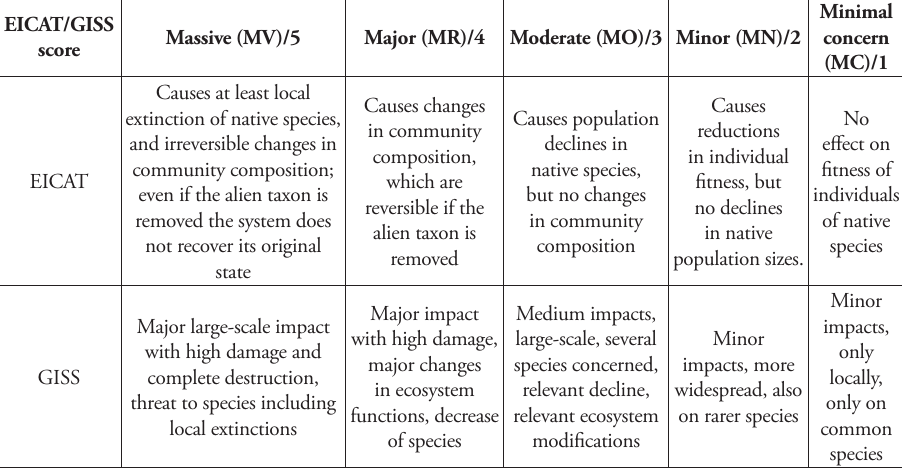
Table 1. Summary of GISS and EICAT scores applied across mechanisms (e.g., competition, hybridisa- tion, etc.). See Hawkins et al. (2015) and Nentwig et al. (2016) for details of